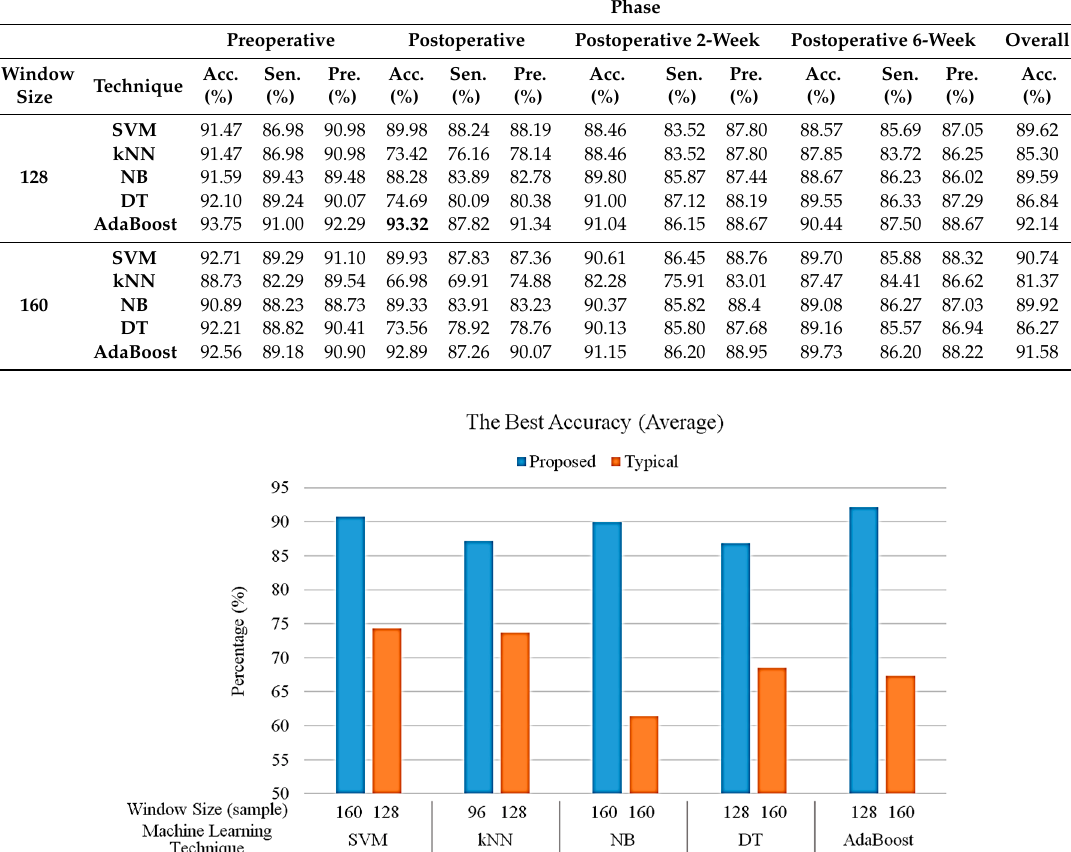
Table 2. The preliminarily investigated results of the performances of multi-classifiers and single classifiers.